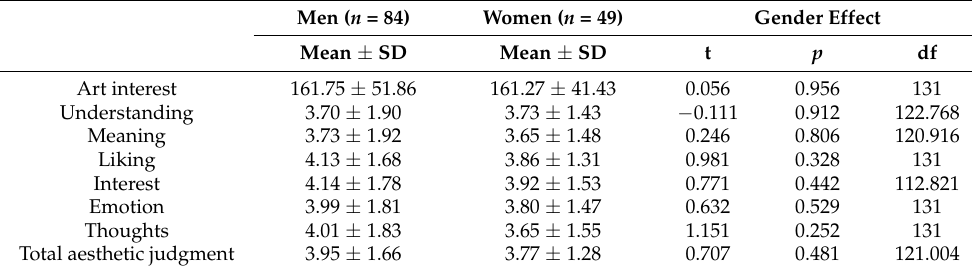
Table 4. Descriptive Statistics and Gender Differences in All Study